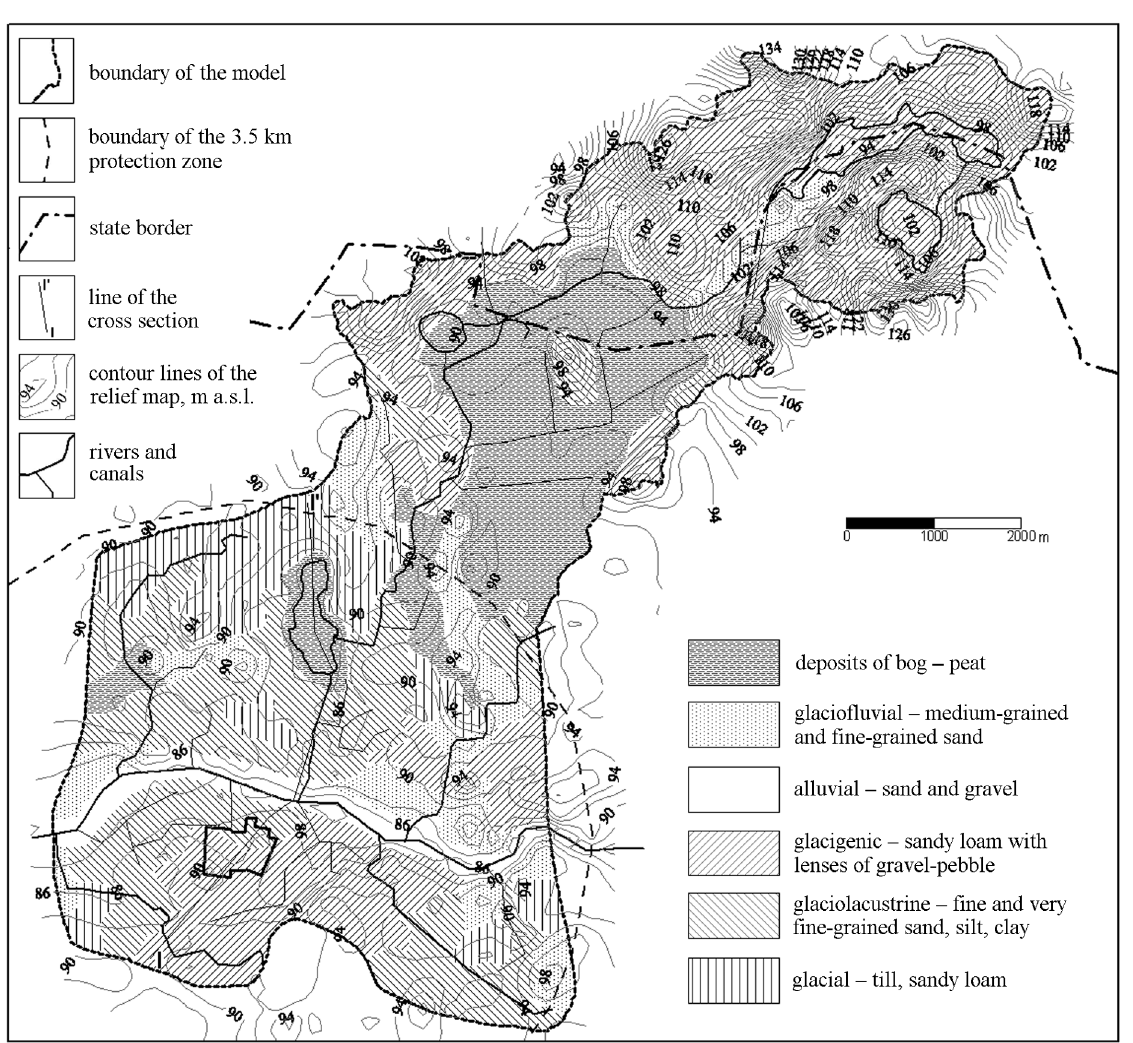
Fig. 2. The Č edasai modelling area and lithological scheme of the top layer (cid:150) Quaternary deposits.